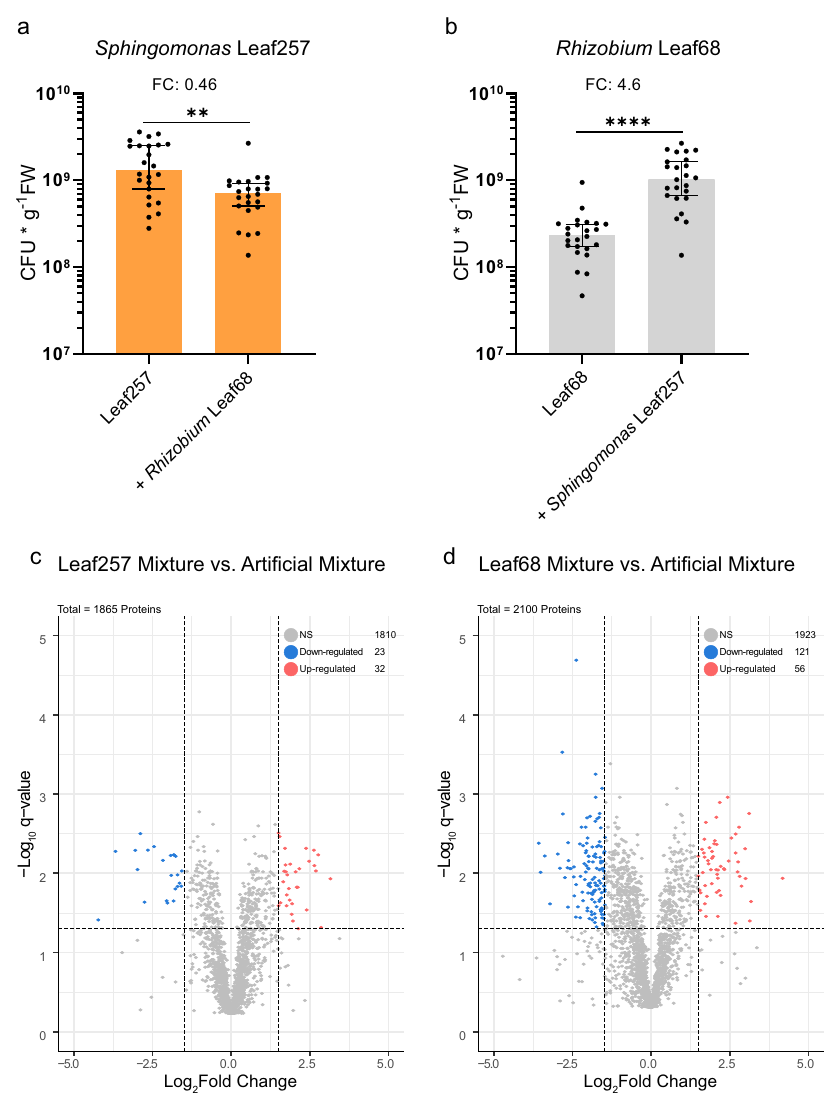
Fig. 2 Changes in the colonization potential and proteomes upon co-colonization of Arabidopsis thaliana . a , b Cell numbers (CFUs per gram fresh weight) of Sphingomonas Leaf257 (orange), or Rhizobium Leaf68 (gray) alone and upon co-colonization harvested after 11 dpi. Average fold-change (FC) between the two conditions is indicated above the bar. Graphs depict the combined data from four independent biological replicates with each dot representing the CFUs obtained from a single plant with six plants per biological replicate ( n = 24). In the graphs, the median and 95% con fi dence interval are shown. Statistical analysis was performed using the Kruskal – Wallis test ( P -values: * p -value < 0.05, ** p -value < 0.01, *** p -value < 0.001, and **** p -value < 0.0001). Proteome changes are depicted as volcano plots for ( c ) Leaf257 during co-colonization of the plant with Leaf68 and ( d ) Leaf68 during co- colonization of the plant with Leaf257.) Proteomics data were obtained from four independent biological replicates ( n = 4) (see methods). The adjusted P - value ( q -value) cutoff was set to 0.05 (horizontal line) and Log 2 Fold change cutoffs are set to >1.5 or < − 1.5 (vertical lines). In the graphs, only proteins detected with at least two unique peptides are shown. The total number of proteins, not signi fi cantly regulated (NS), and Down- / Up-regulated are